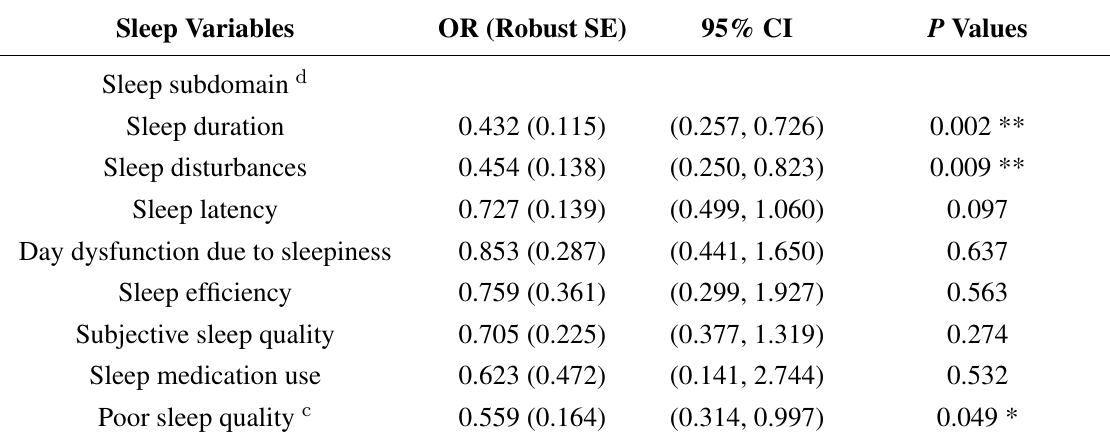
Table 3. Adjusted regression models a of sleep quality in adolescence on concurrent blood zinc concentrations b